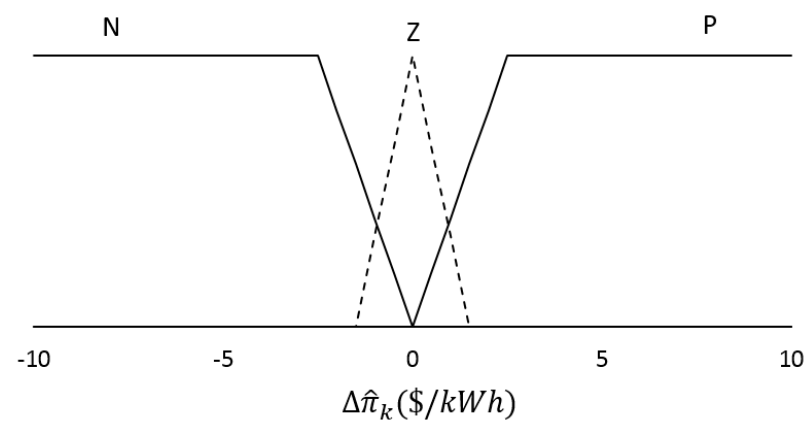
Figure 3. Membership functions for ∆ ˆ π k .